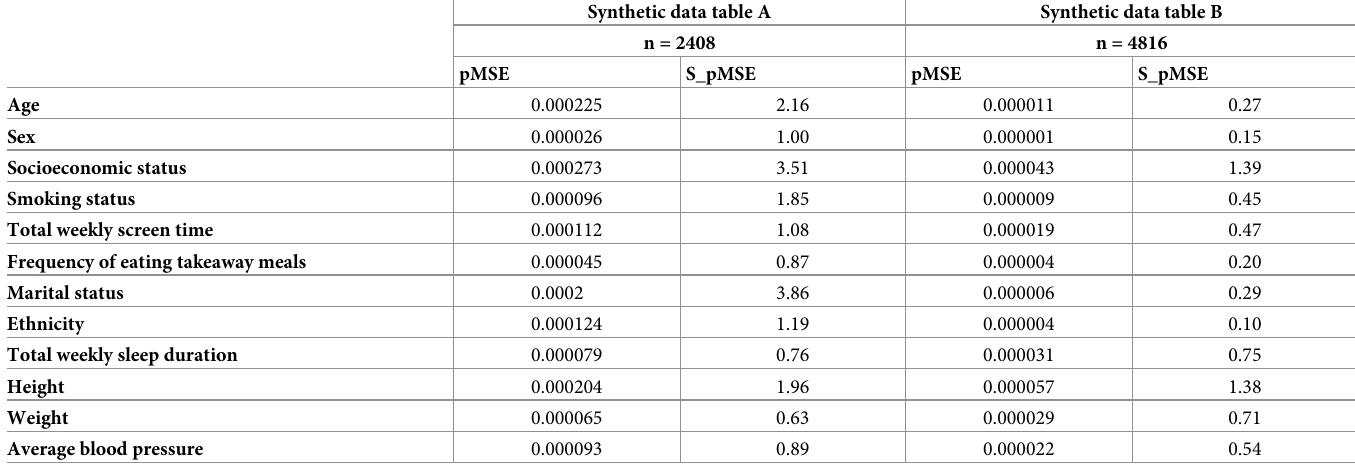
Table 2. Statistical analysis comparing synthetic data tables to the real training dataset (n = 2408). Presented are propensity score mean-squared-error and standard- ised ration of propensity score mean-squared error. Synthetic data table A